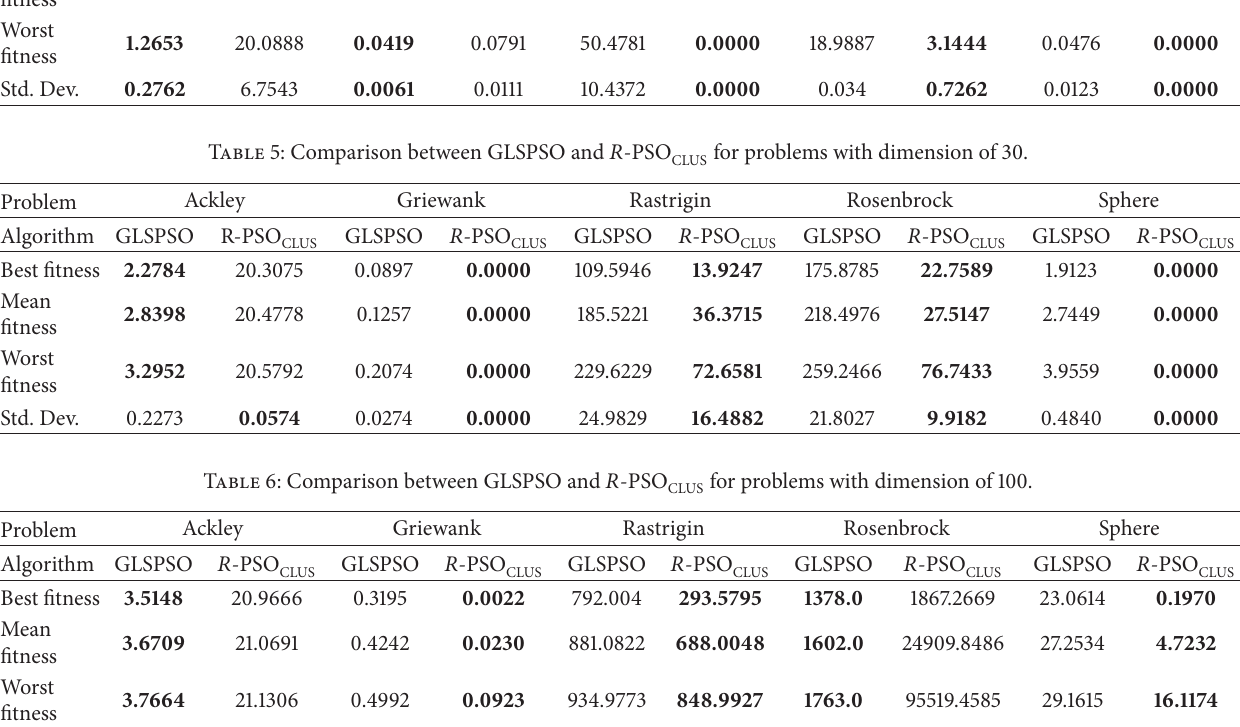
Table 7: Comparison between GLSPSO and 𝐿 -PSO